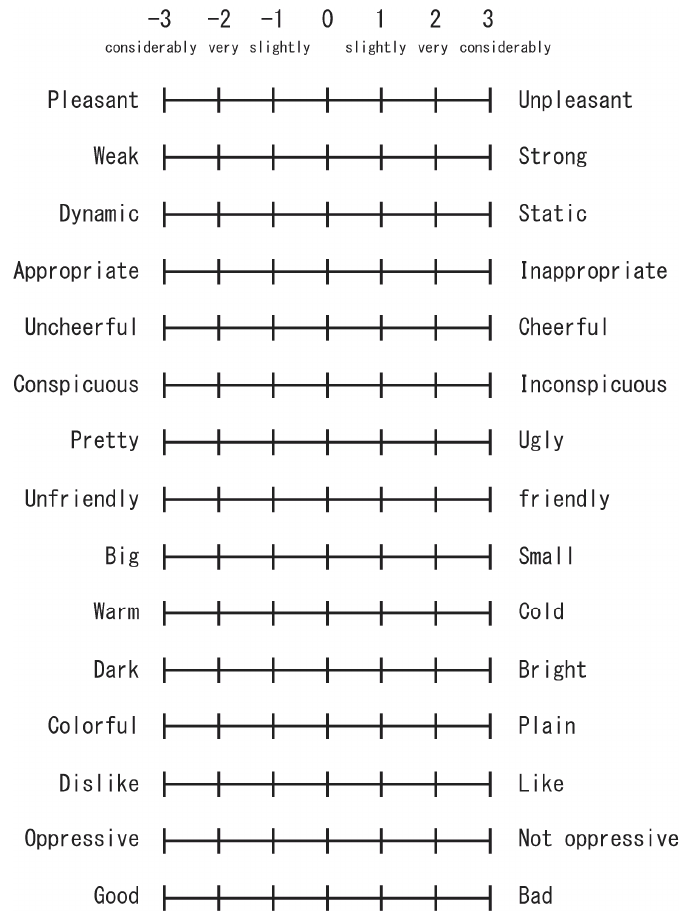
Figure 5. Categories for the oppressive feeling scale.